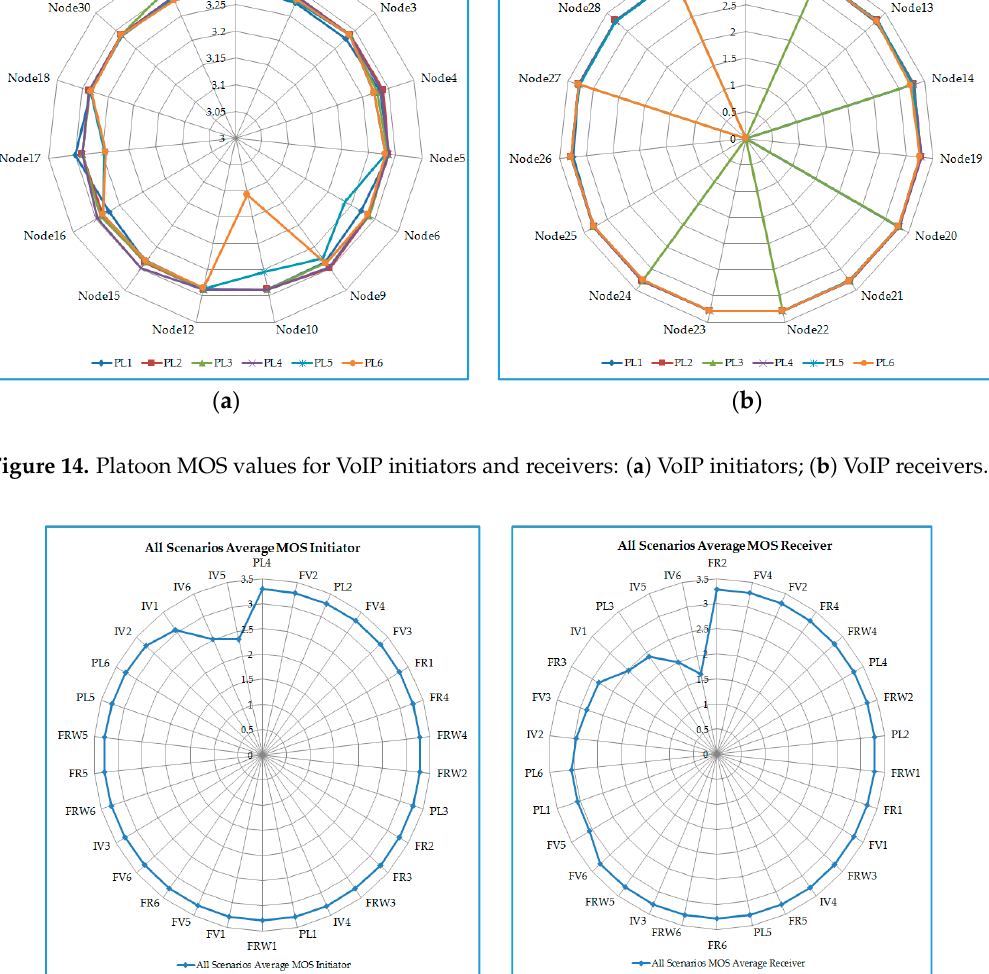
Figure 15. All scenarios’ MOS values comparison for: ( a ) VoIP initiators; ( b ) VoIP receivers.